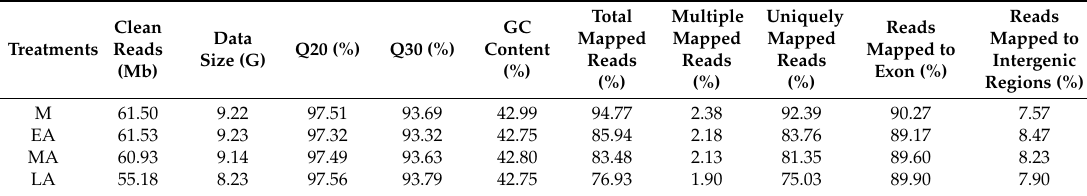
Table 2. Summary of sequencing data.